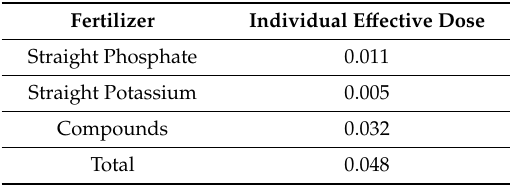
Table 5. Annual individual e ff ective dose ( µ Sv / a) 1 year after the occasional spreading of fertilizers for the region of